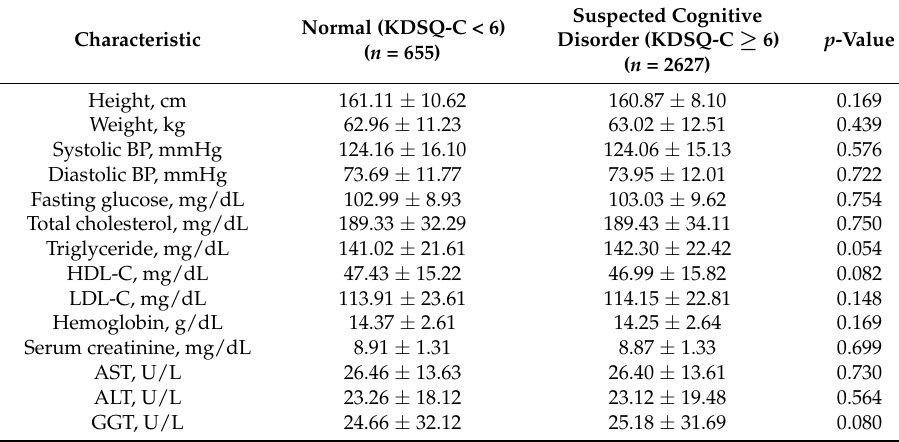
Table 2. Characteristics of subjects at high-risk of cognitive disorders according to the Korean Dementia Screening Questionnaire-Cognition (KDSQ-C)